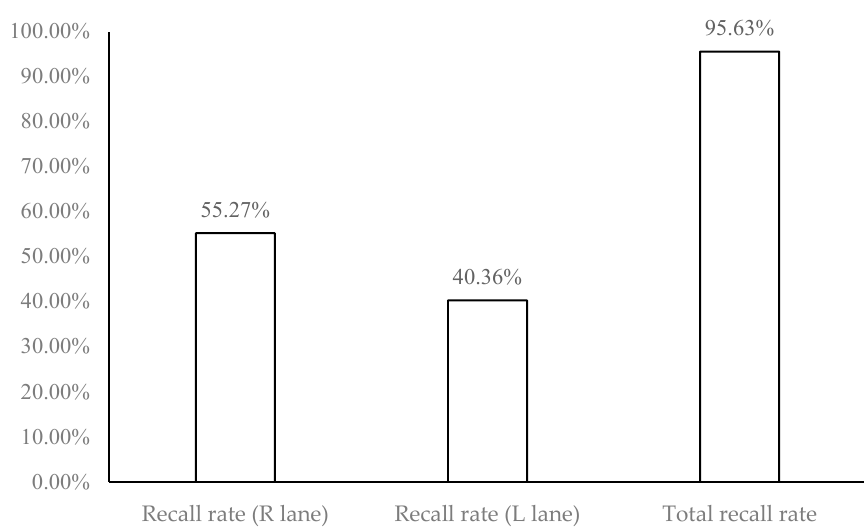
Figure 9. The recall rate and total recall rate for vehicle license plate.